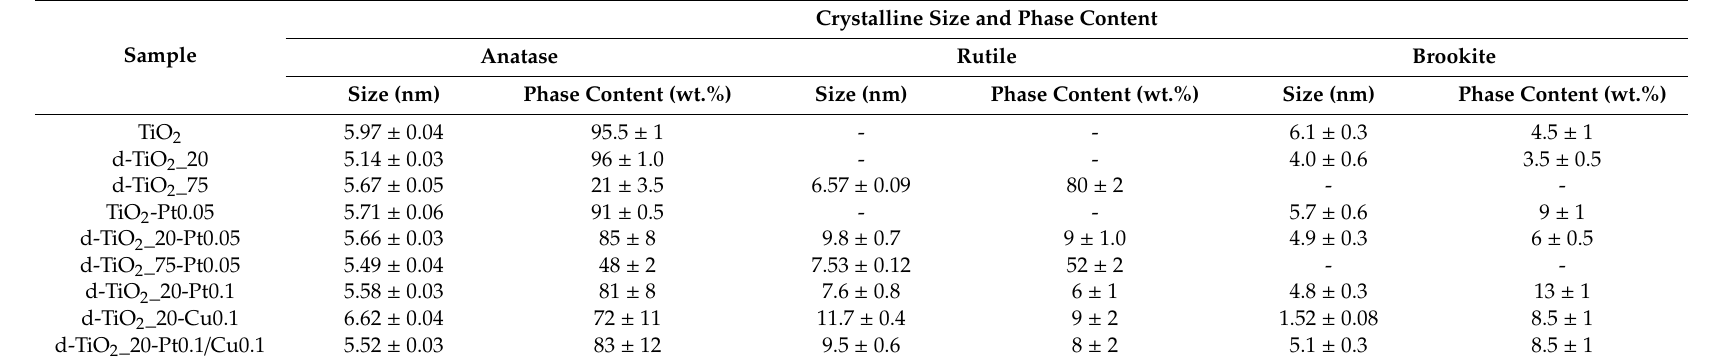
Table 3. Crystalline phases characteristic for obtained defective d-TiO 2 -Pt / Cu samples.